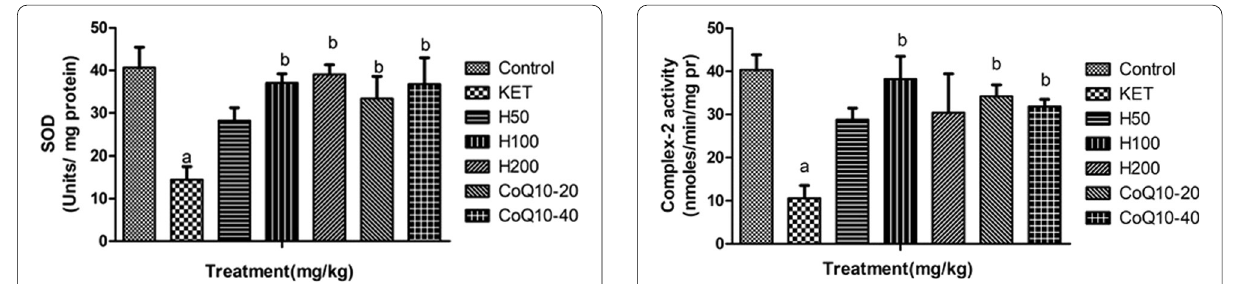
Fig. 10 Effect of hesperidin and Coenzyme Q10 on brain SOD levels in the hippocampus region of the brain. Data were analyzed by one-way ANOVA followed by Tukey’s post hoc analysis. All values were expressed as Mean SEM. a p < 0.05 as compared to naive, ± b p < 0.05 as compared to ketamine. KET, Ketamine; H, Hesperidin;